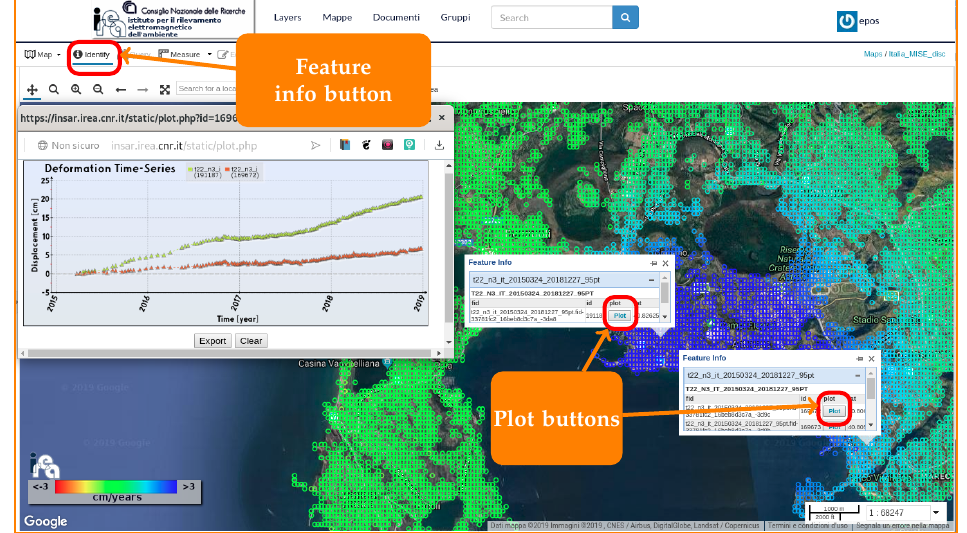
Figure 15. Example of the implemented deformation time-series plot visualization and analysis functionality.